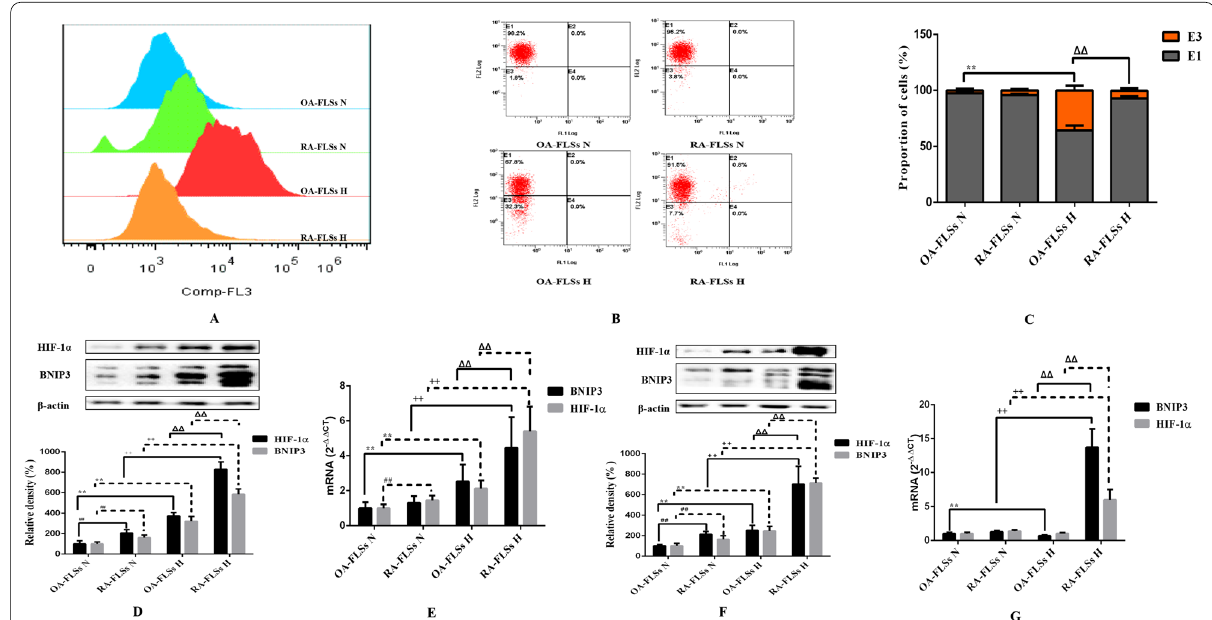
Fig. 4 Effect of hypoxia on oxidation indexes in OA-FLSs and RA-FLSs. A Cells were exposed to 21% or 2% O 2 for 24 h and assessed the ROS content by flowcytometry using 10 μM CM-H2DCFDA as a ROS probe; B JC-1 was used to detect the effect of hypoxia on MMP of OA-FLSs and RA-FLSs; C Histogram depicts the quantitative data from the JC-1 staining (mean SD, n 6 from three independent experiments); D The expressions ± = of HIF-1α and BNIP3 in OA-FLSs and RA-FLSs after hypoxia for 12 h were analyzed by Western blot (mean SD, n 6 from three independent ± = experiments); E The expressions of HIF-1α and BNIP3 in OA-FLSs and RA-FLSs after hypoxia for 12 h were analyzed by RT-qPCR (mean SD; n 6 ± = from three independent experiments); F The expressions of HIF-1α and BNIP3 in OA-FLSs and RA-FLSs after hypoxia for 24 h were analyzed by Western blot (mean SD; n 6 from three independent experiments); G The expressions of HIF-1α and BNIP3 in OA-FLSs and RA-FLSs after ± = hypoxia for 24 h were analyzed by RT-qPCR (mean SD; n 6 from three independent experiments). # P < 0.05, ## P < 0.01 represents the comparison ± = between OA-FLSs N and RA-FLSs N; *P < 0.05, **P < 0.01 represents the comparison between OA-FLSs N and OA-FLSs H, + P < 0.05, ++ P < 0.01 represents the comparison between RA-FLSs N and RA-FLSs H, Δ P < 0.05, ΔΔ P < 0.01 represents the comparison between OA-FLSs H and RA-FLSs